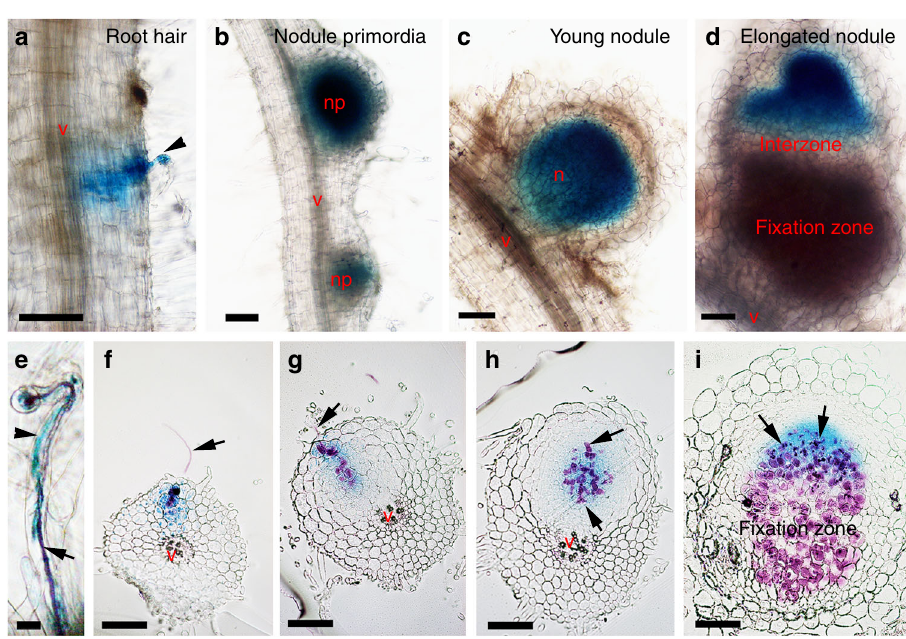
Fig. 2 Expression of VPY is tightly associated with rhizobial infection in root and nodule cells. a – i Images showing pVPY:GUS activity during rhizobial infection in root hair ( a , e ) and in nodules from primordia to mature zonation stages ( b – d , f – i ). Composite transgenic plants were used at different stages after inoculation with Rm1021-lacZ. a – e are whole mount of GUS and/or X-gal stained roots, f – i are longitudinal sections of GUS and X-gal stained nodule primordia/nodule. Blue colour indicates staining of GUS activity and magenta colour indicates staining of rhizobia. Arrowheads indicate GUS stained root hairs ( a , e ) and arrows indicate infection threads in root hairs ( a , e ) or nodule primordia ( f – h )/nodule ( i ). v, central vasculature of the root; np, nodule primordium; n, nodule. Scale bars, 100 µ